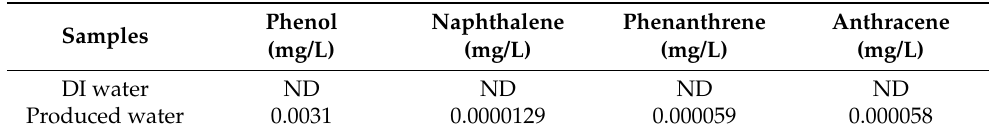
Table 3. The content of phenols and polycyclic aromatic hydrocarbons in DI water and produced